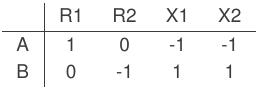
Table 2: Example one: stoichiometric matrix,